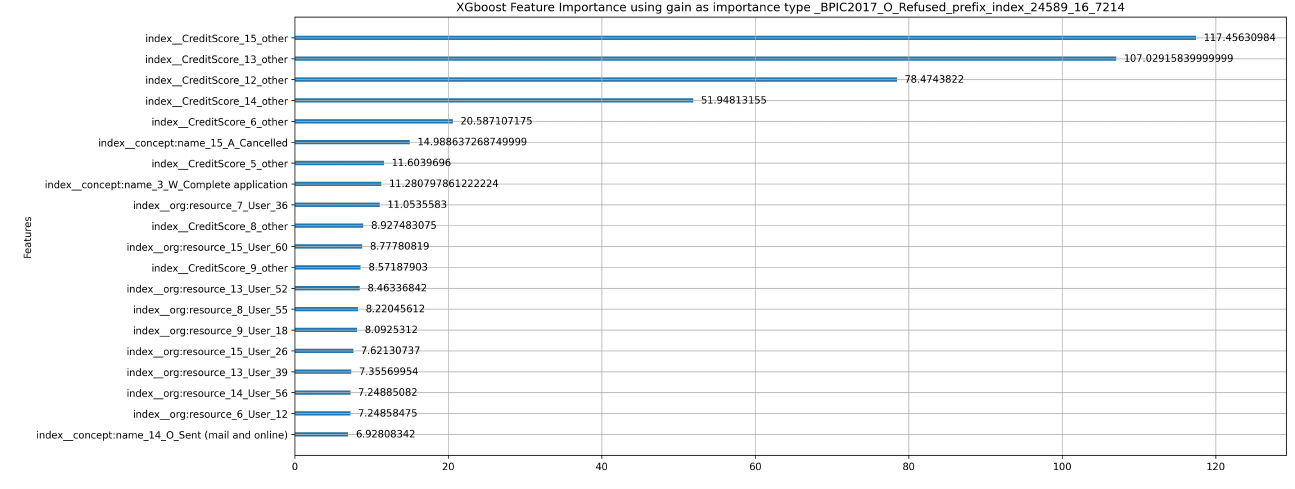
Figure 9. XGBoost features importance (gain) for prefix length (16) BPIC2017_Refused